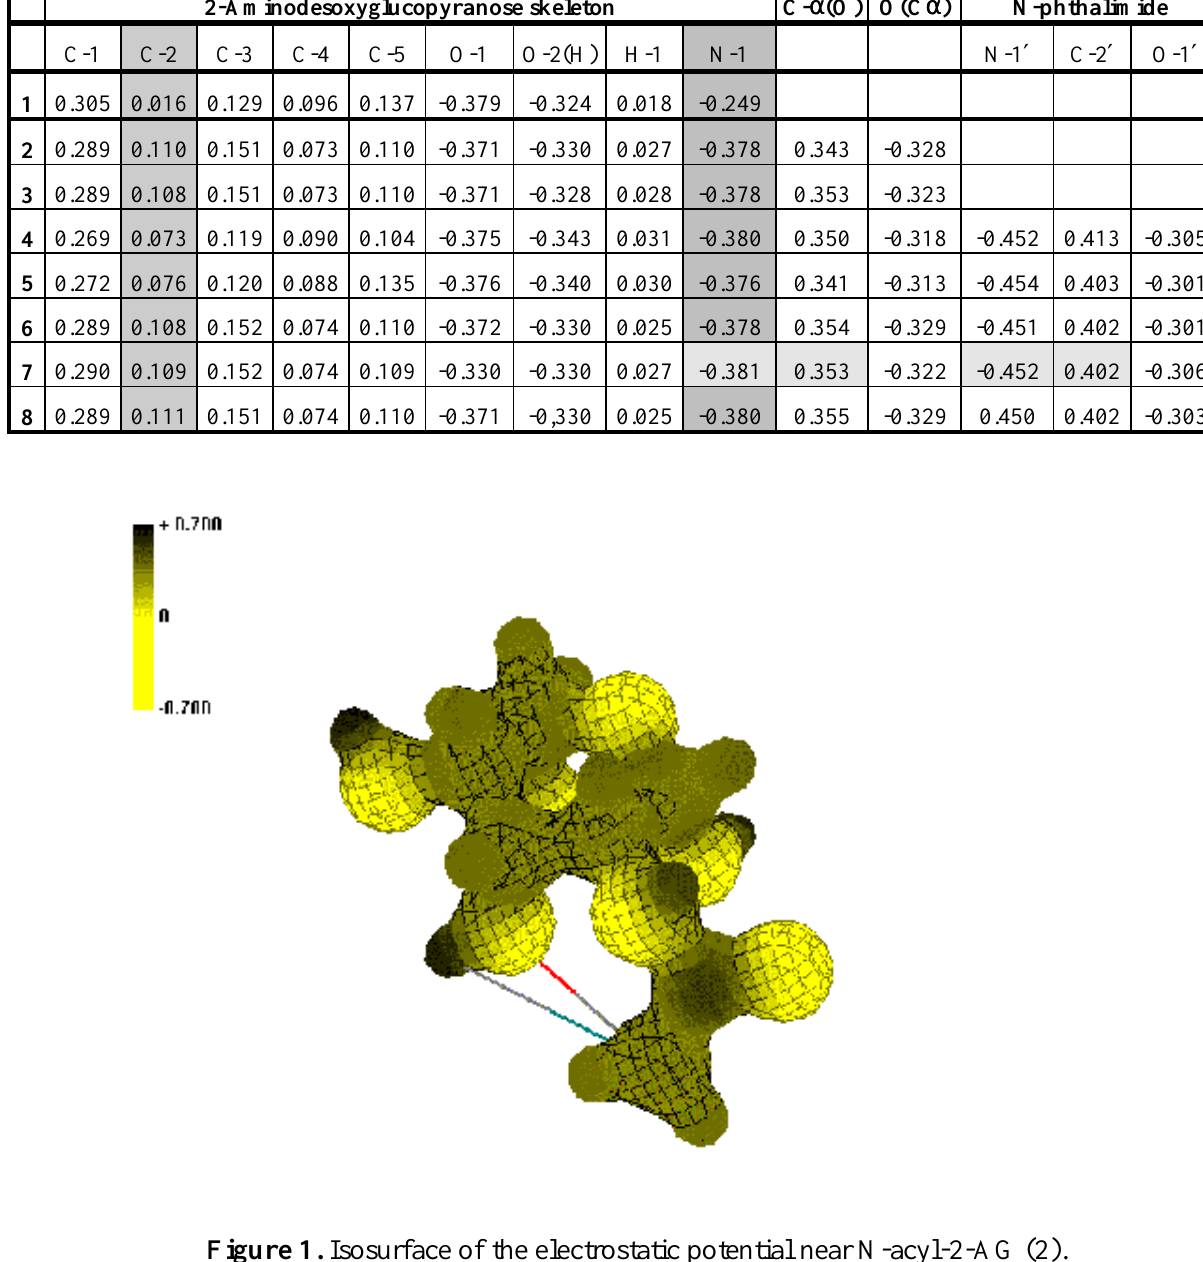
Figure 1. Isosurface of the electrostatic potential near N-acyl-2-AG